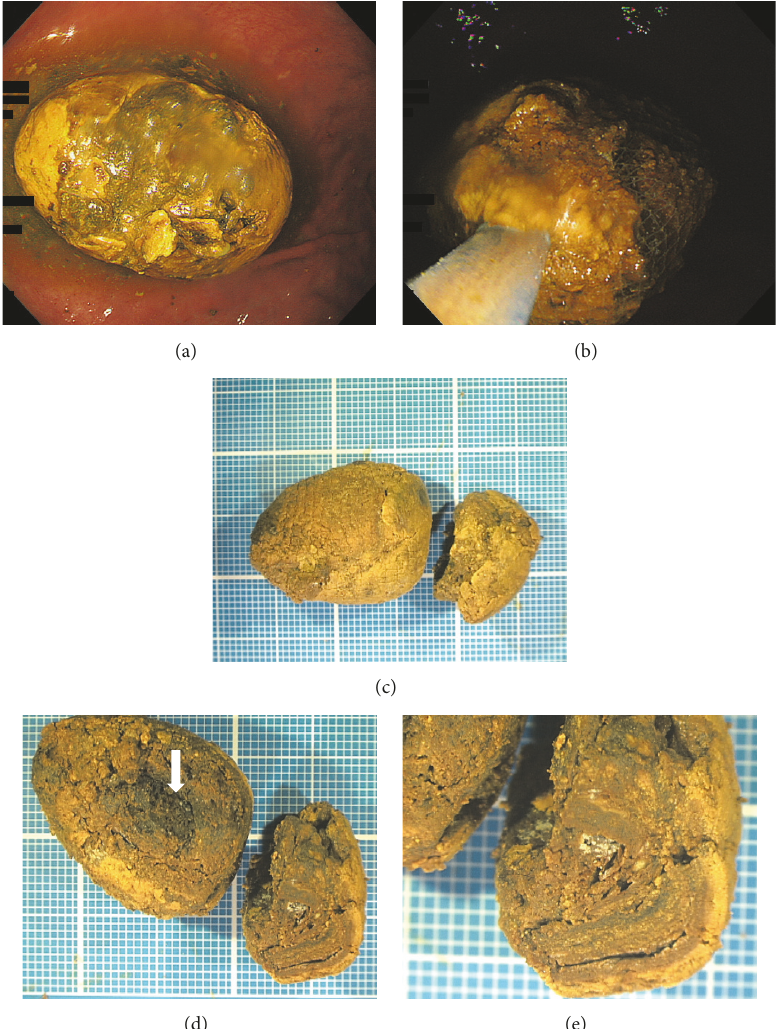
Figure 1: Images of a gastric bezoar. Esophagogastroduodenoscopy revealed a bezoar in the stomach (a), which was endoscopically retrieved (b). The surface of the bezoar was yellowish (c), and the cut surface showed laminar structure (d, e). Each grid section is a 1 mm square